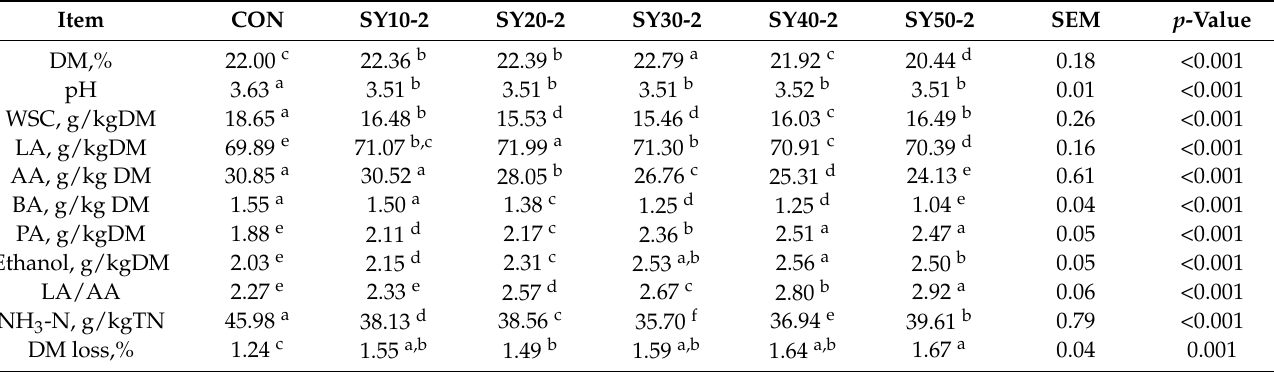
Table 3. Fermentation quality of corn silages.